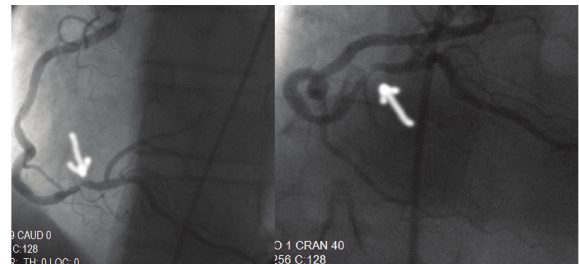
Figure 2: Critical lesion in right coronary